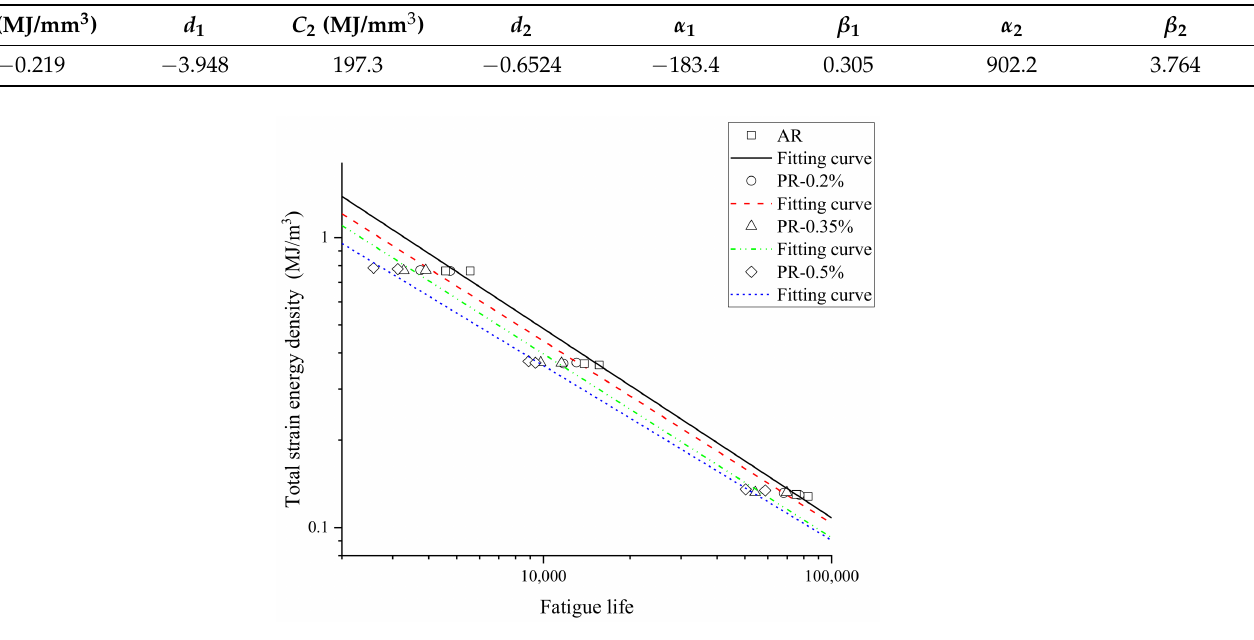
Figure 11. Total strain energy density and fatigue life curve.